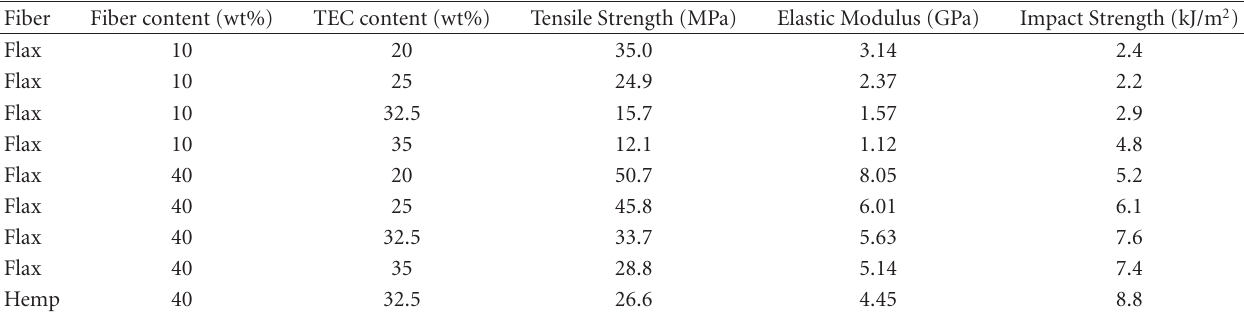
Table 2: Mechanical properties of flax and hemp fiber